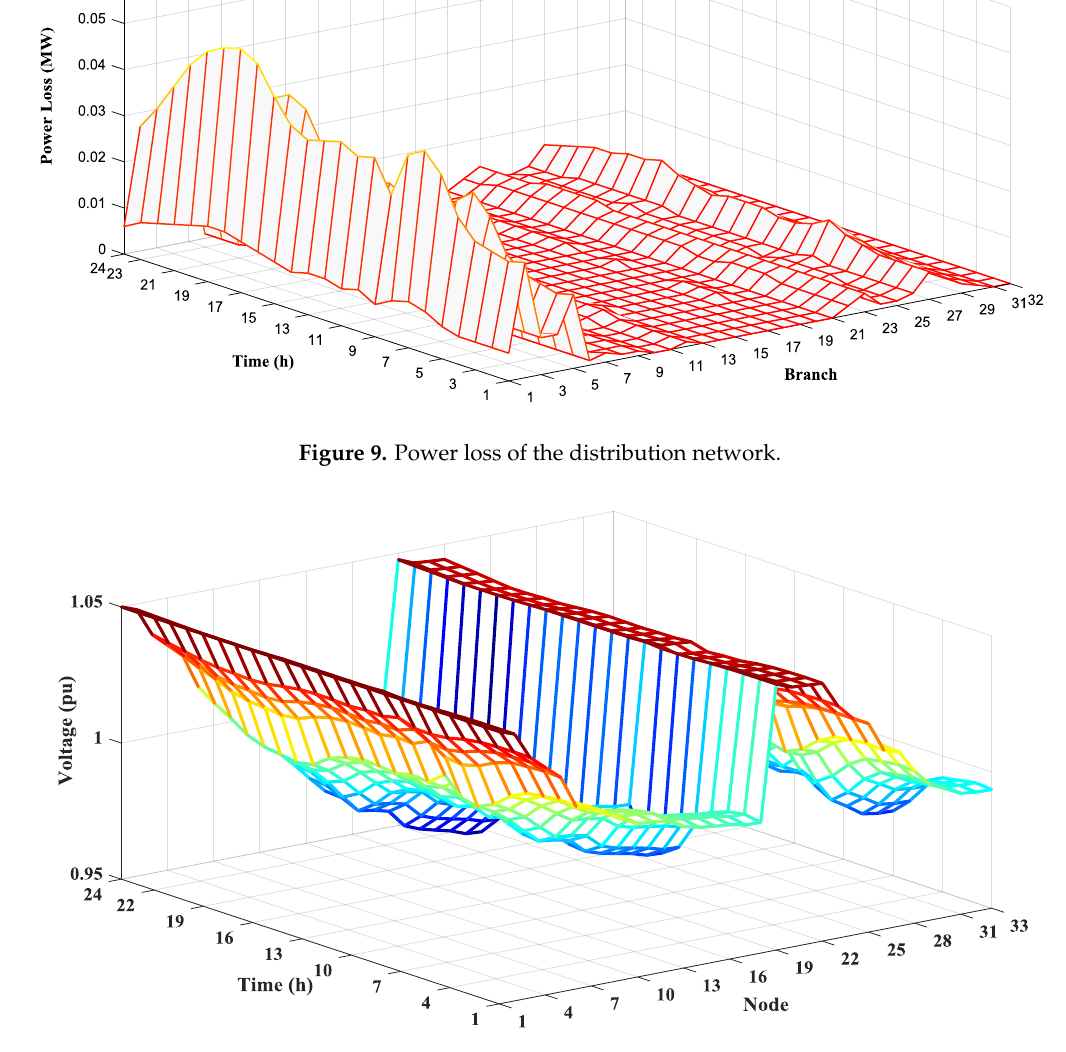
Figure 10. Node voltage of the distribution network.